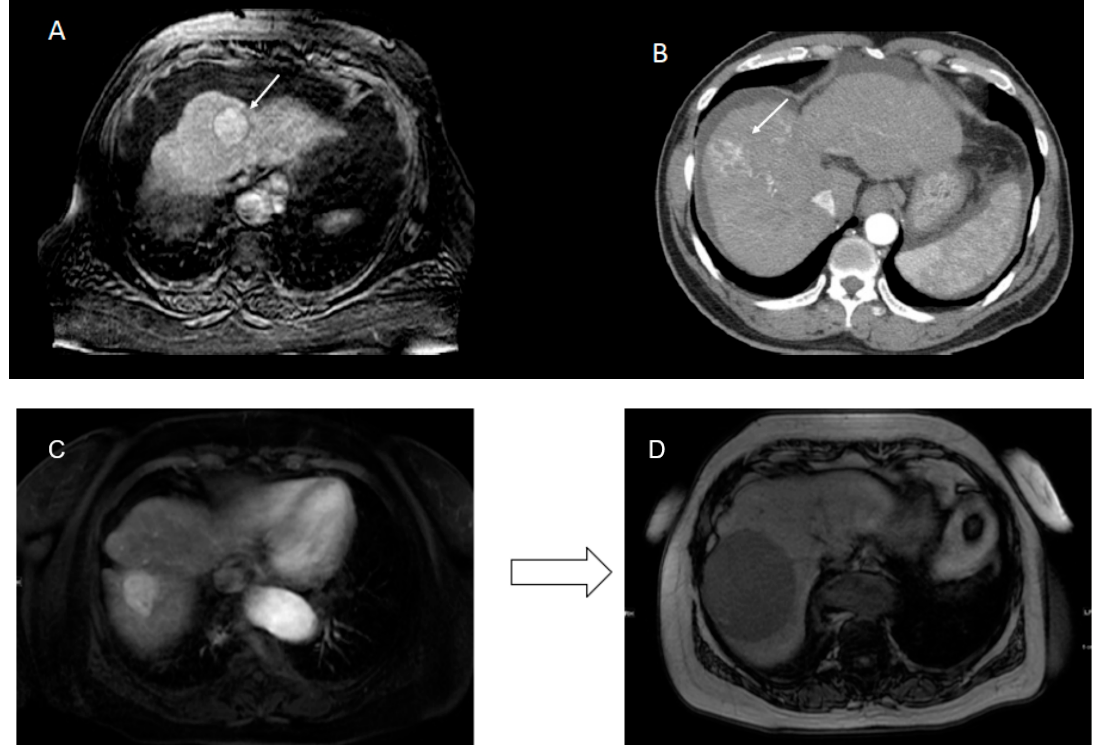
Figure 2. The included cases were separated based on imaging modality CT versus MRI and well-circumscribed ( A ) versus irregular margin ( B ); Example of rapidly progressive subtype of hepatocellular carcinoma progression in patient. Tumor increased in size from 3.3 ( C ) to 8.8 cm ( D ) in a period of 12 months, showing rapid growth in the same patient. Table 1. Demographic data, comorbidities, Child-Pugh Class, and mean MELD score. None of the factors reached statistical significance between RPHCC and control tumors at p < 0.05.